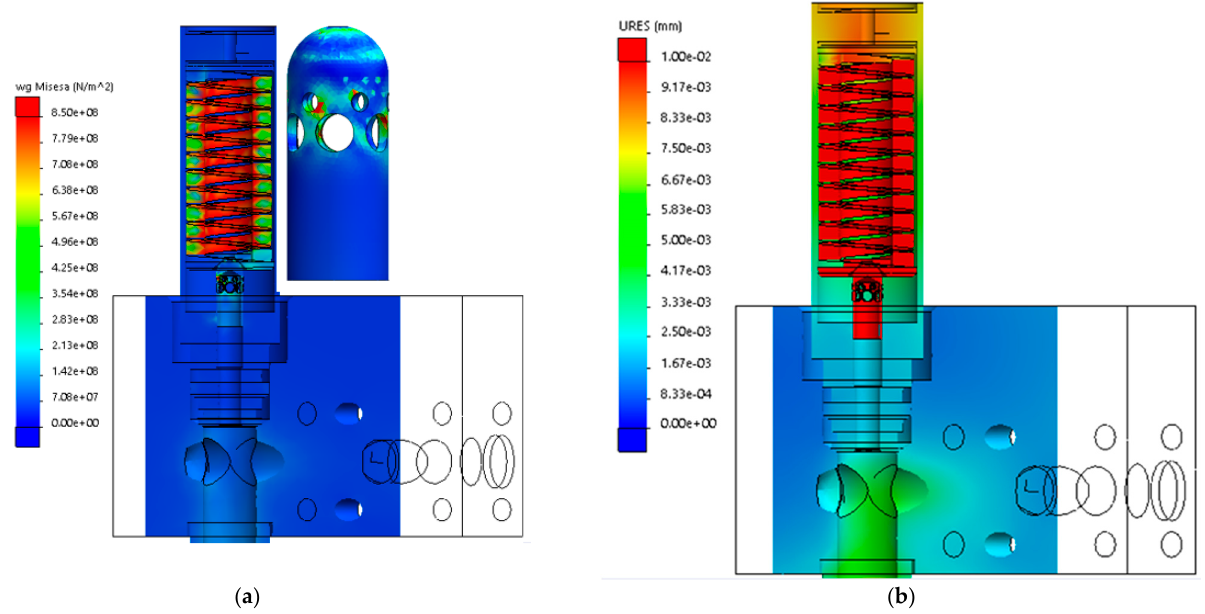
Figure 25. The variation map of von Misses stress ( σ ) ( a ) and displacement ( d) ( b ) for a 0.01335 m 3 ·s -1 volume flow rate (800 L·min -1 ).